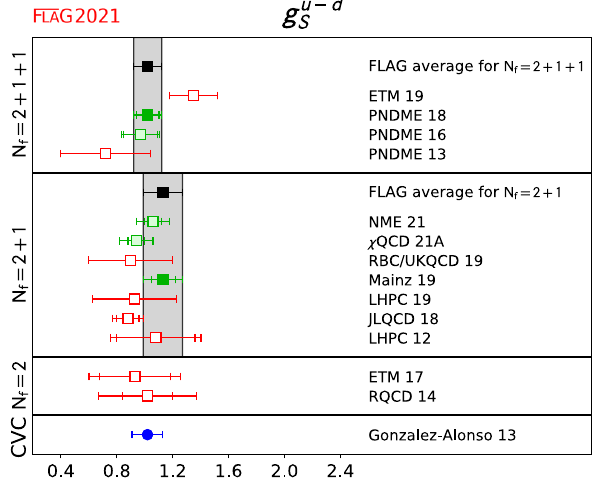
for N f = 2, 2 + 1, and 2 + 1 + 1 flavour calculations. Also S